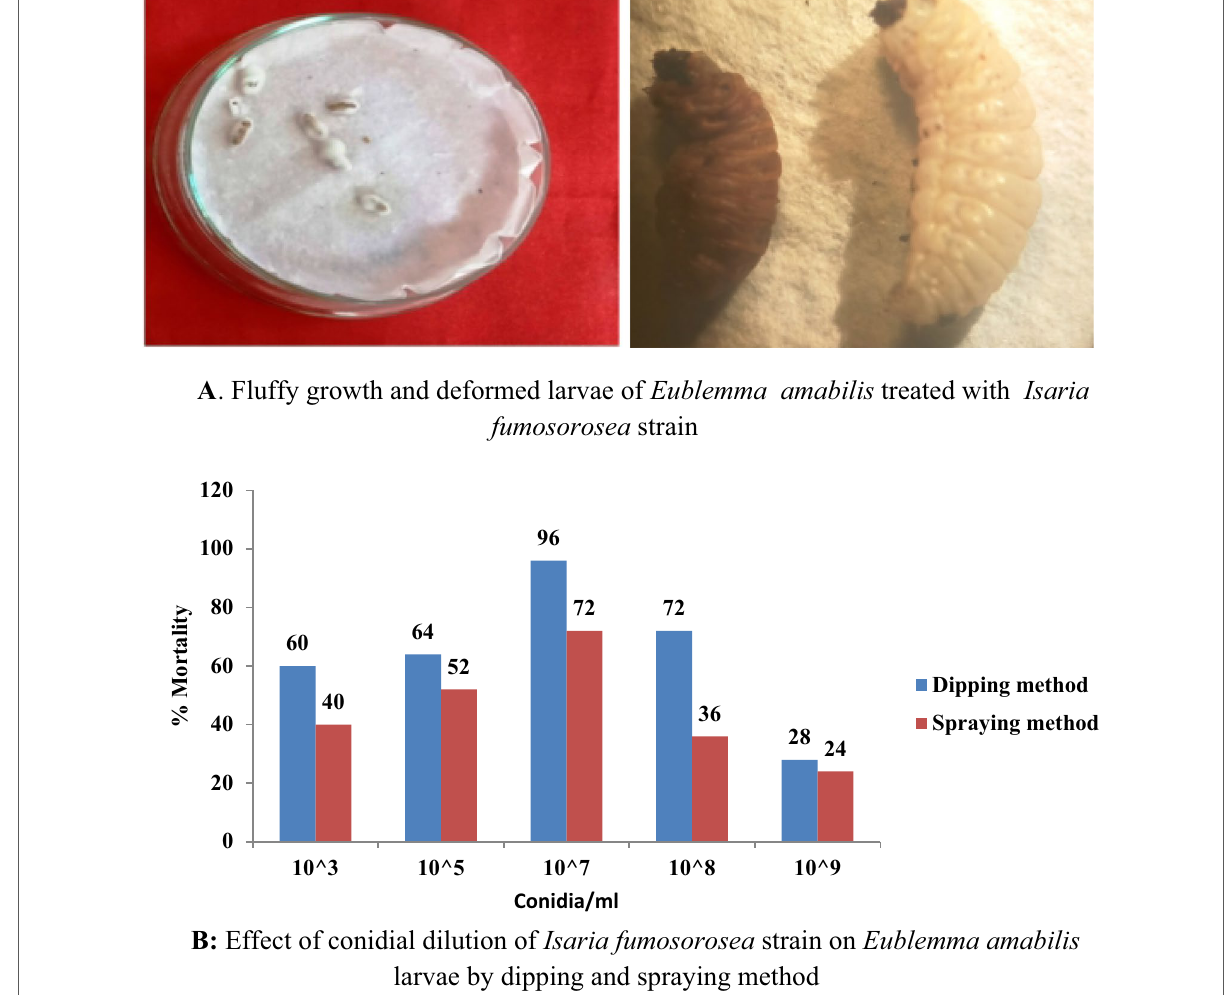
Fig. 6 a Fluffy growth and deformed larvae of Eublemma amabilis treated with Isaria fumosorosea strain. b Effect of conidial dilution of Isaria fumosorosea strain on Eublemma amabilis larvae by dipping and spraying